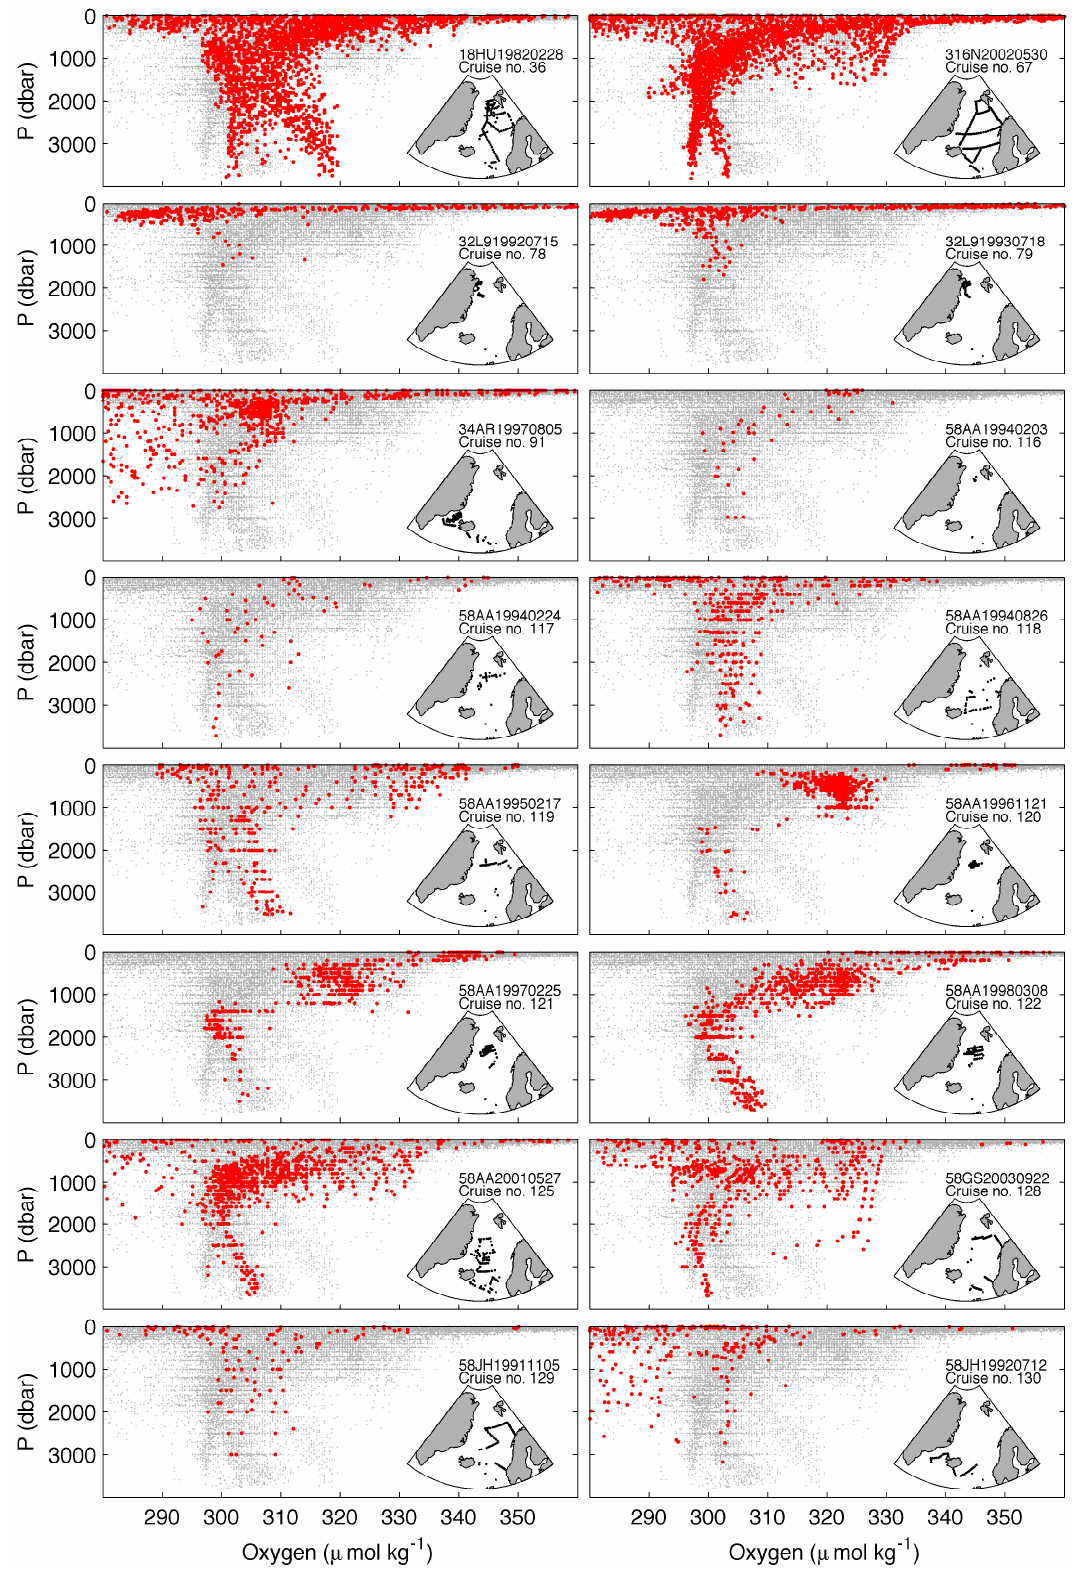
Figure 2. Station positions and oxygen data of Nordic Seas CARINA cruises after secondary QC. All data shown in grey and specific cruise in